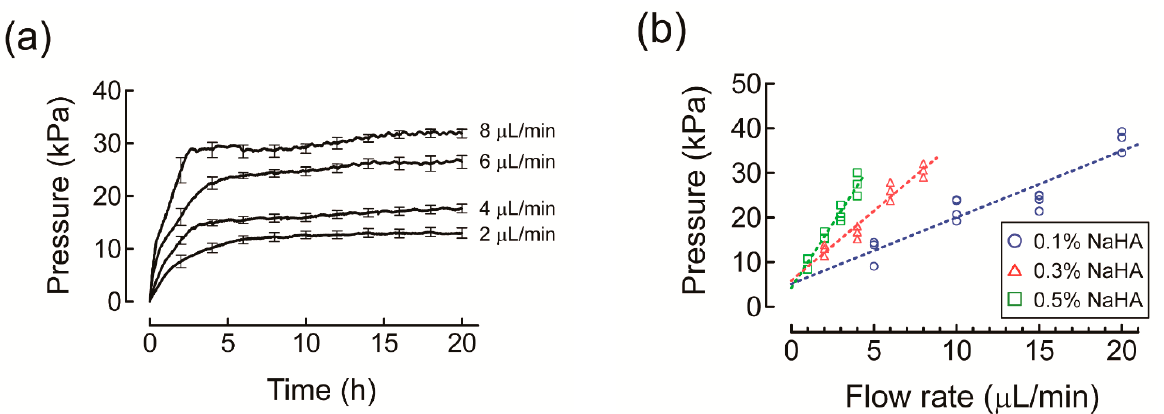
Figure 6. ( a ) Time course of changes in hydrostatic pressure in the pressure tube for 0.3% sodium hyaluronic acid solution (NaHA) at different infusion rates of phosphate buffered saline (PBS) in the measurement of Darcy’s permeability coefficient of NaHA solution. Experiments were carried out at 25 °C. For simplicity, values are presented as mean and standard error for every 2 h. ( b ) Relationship between infusion rates of PBS and hydrostatic pressure in the pressure tube at plateau for different concentrations of NaHA solution fitted with linear regression lines (dashed lines).